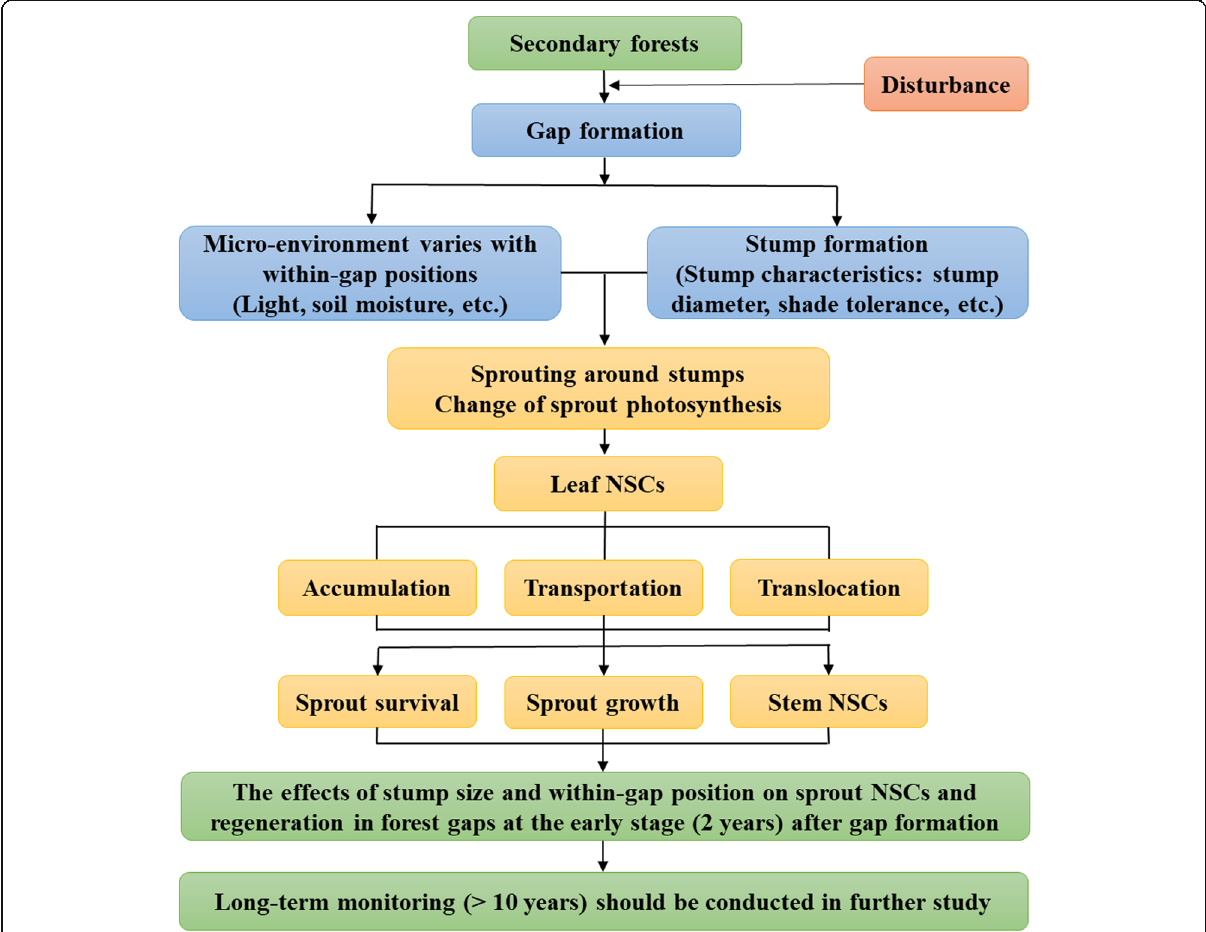
Fig. 1 Flow chart of the current understanding and missing holes regarding secondary forest sprout regeneration in